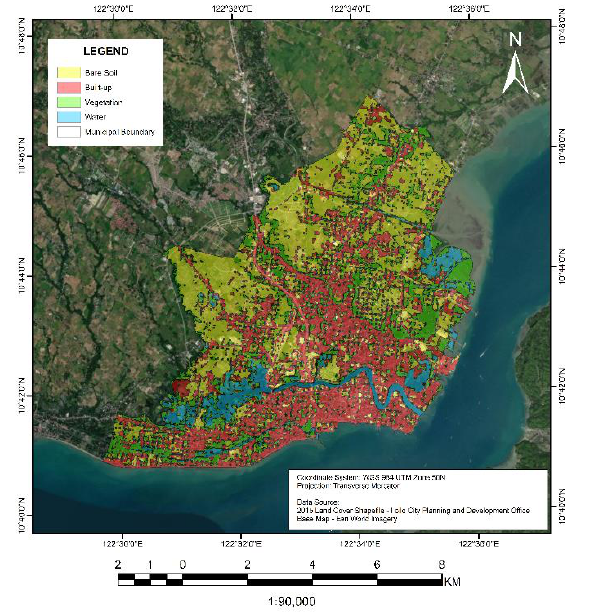
Figure 1. Land cover map of Iloilo City